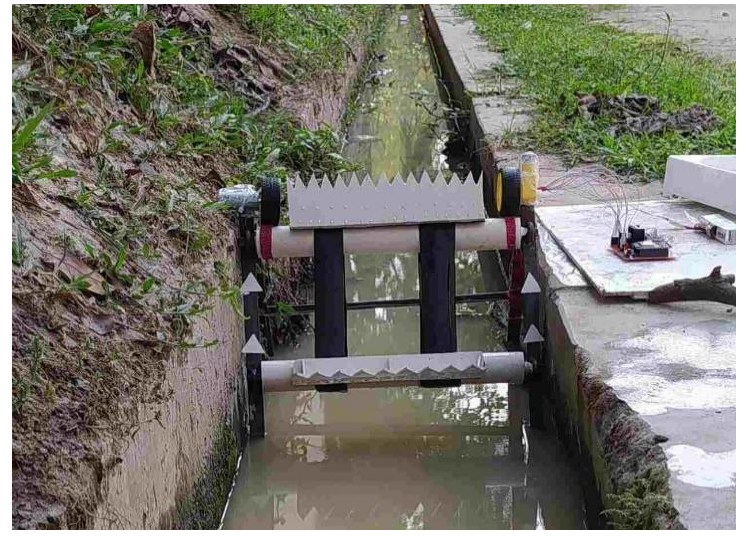
Figure 7. System prototype running in a drain of DUET.